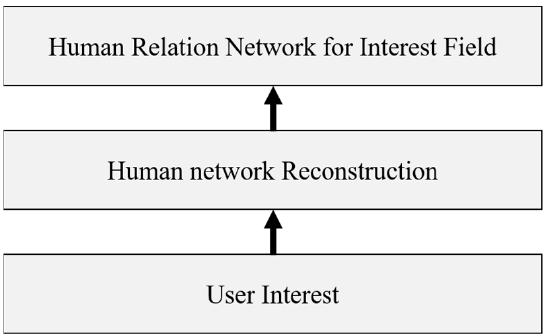
Figure 3. Procedure of determining human relation by field of interest.